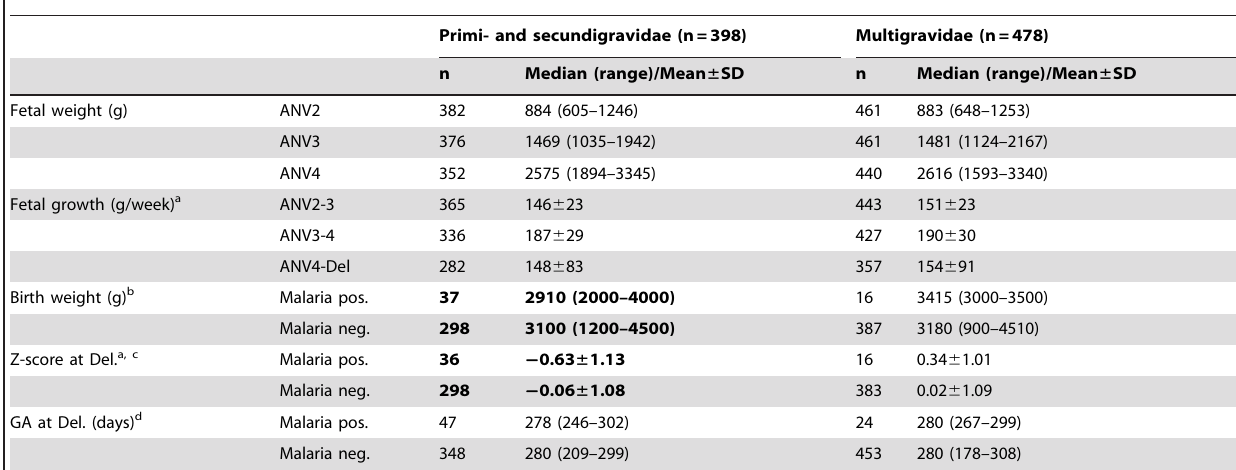
Table 2. Fetal weight, fetal growth, birth weight and gestational age at delivery.